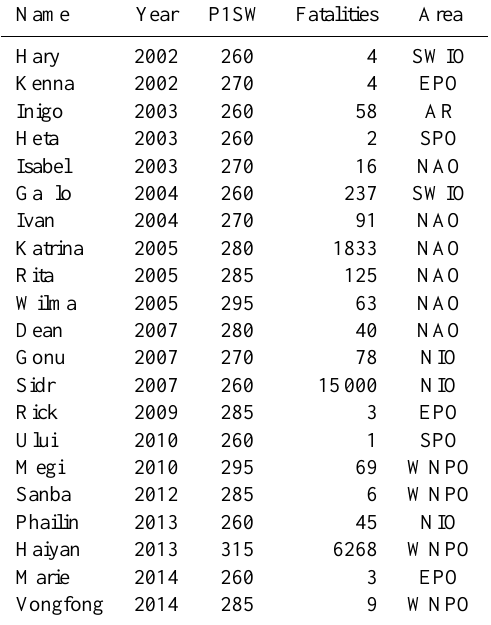
Table 1. List of tropical cyclones of Category 5 Saffir–Simpson scale with fatalities recorded in the 20th century. P1SW: peak 1min sustained wind in kmh − 1 ; NAO: North Atlantic Ocean; EPO: east- ern Pacific Ocean; WNPO: west North Pacific Ocean; NIO: north Indian Ocean; SWIO: southwest Indian Ocean; AR: Australian re- gion; SPO: South Pacific